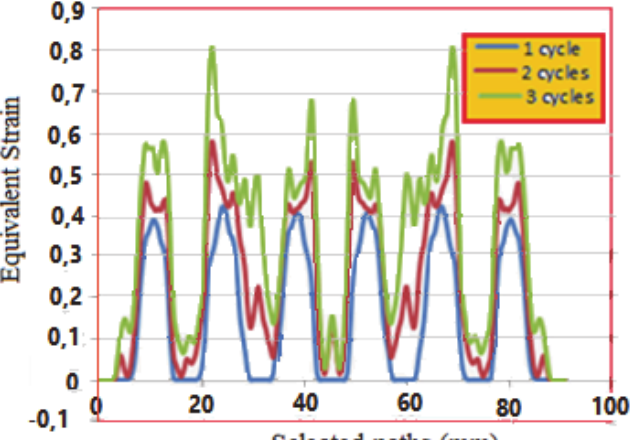
Figure 9: Influence of the number of cycles on the evolution of the plastic strain at the level of the median surface of the sample. Case of a path of the lower face